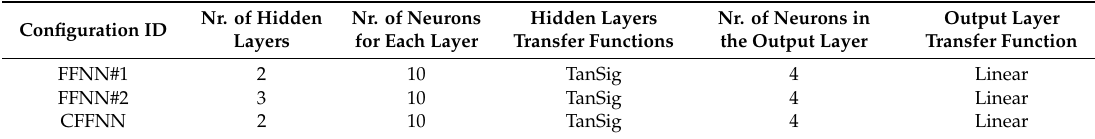
Table 1. ANN configurations and architectural parameters.